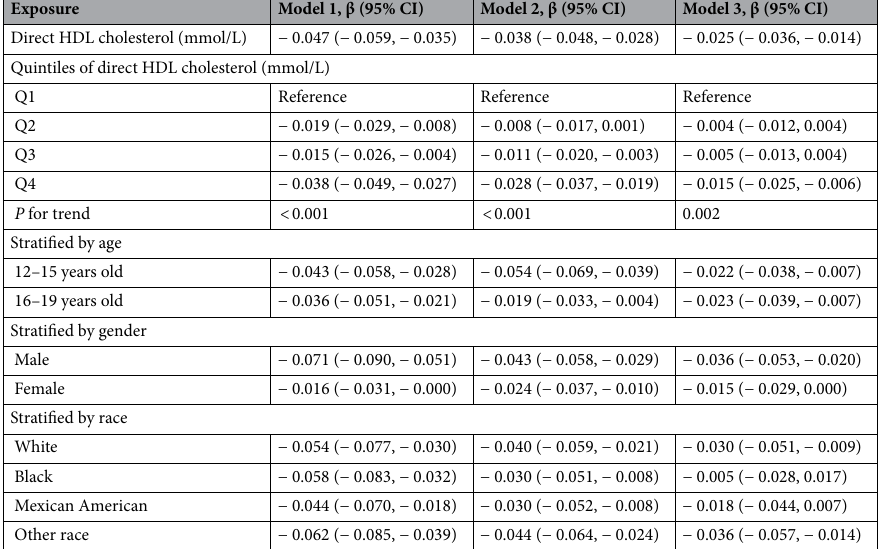
Table 2. Association between high-density lipoprotein cholesterol and total bone mineral density. Model 1: No adjusted. Model 2: Adjusted age, gender, and race. Model 3: Adjusted all covariates were. The stratification variable itself was not adjusted in the subgroup analysis.